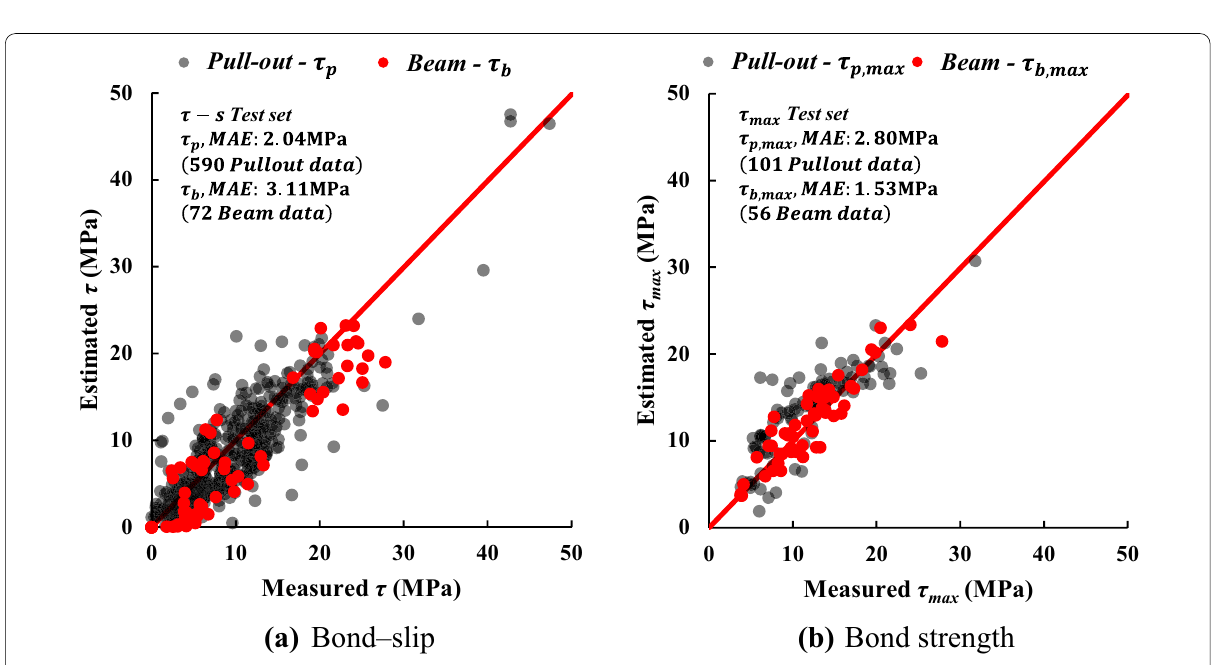
Fig. 10 Comparison of test results and values calculated by proposed